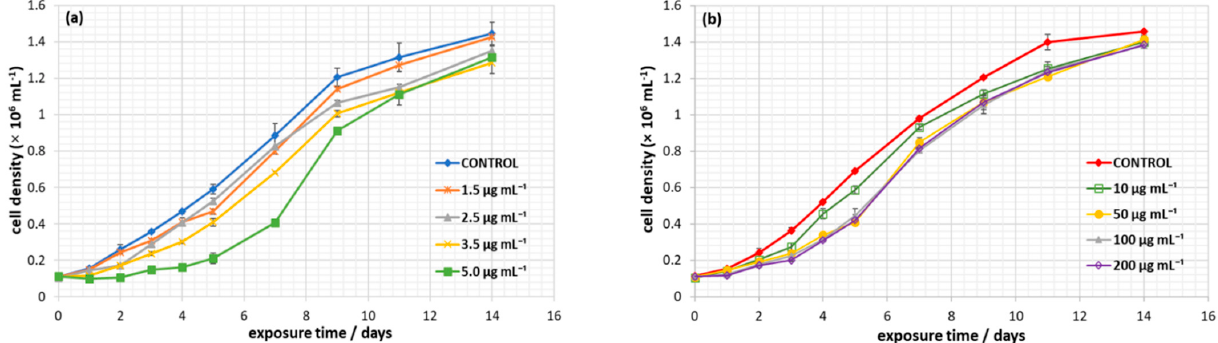
Figure 3. Growth dynamics of Cylindrotheca closterium when exposed to nanoplastics. Growth curves of C. closterium exposed to PS-NH 2 (0–5 µg mL − 1 ) ( a ) and PS-COOH (0–200 µg mL − 1 ) nanoplastics ( b ), as measured by cell density over a 14-day period. Mean values of duplicate determinations with standard deviations are shown.